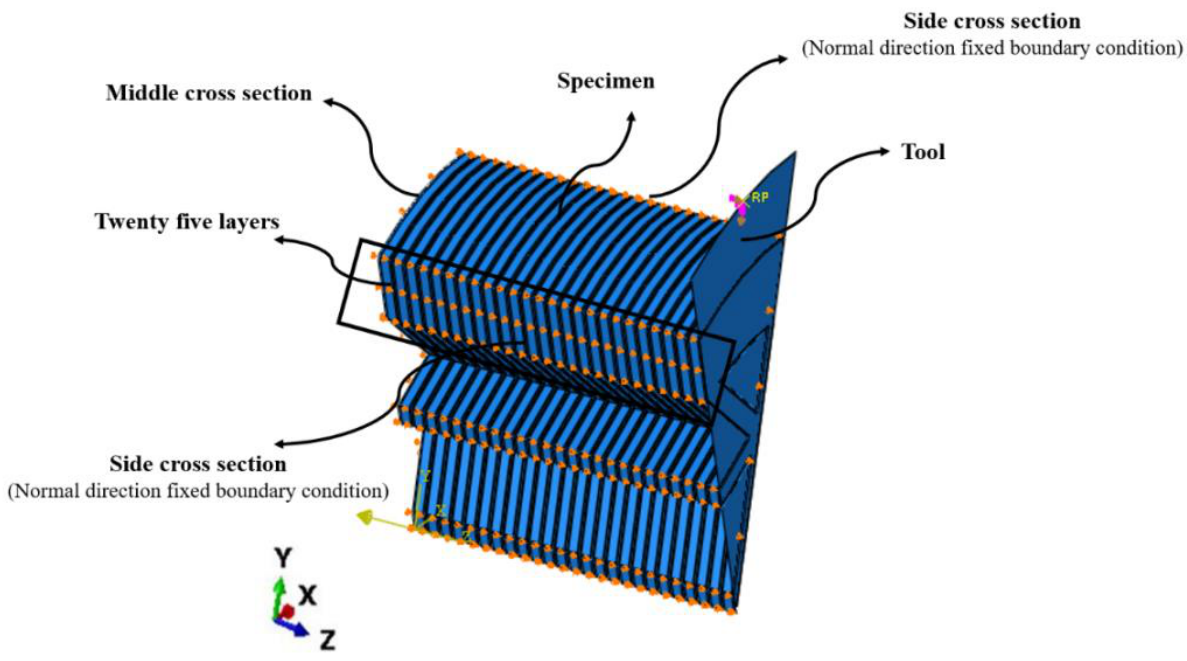
Figure 7. Three-dimensional model of the MEX-produced specimen with boundary conditions assigned to the middle cross-section of the model, the amount of layers of the model, and tool (orange points represent the boundary conditions that applied to the model).